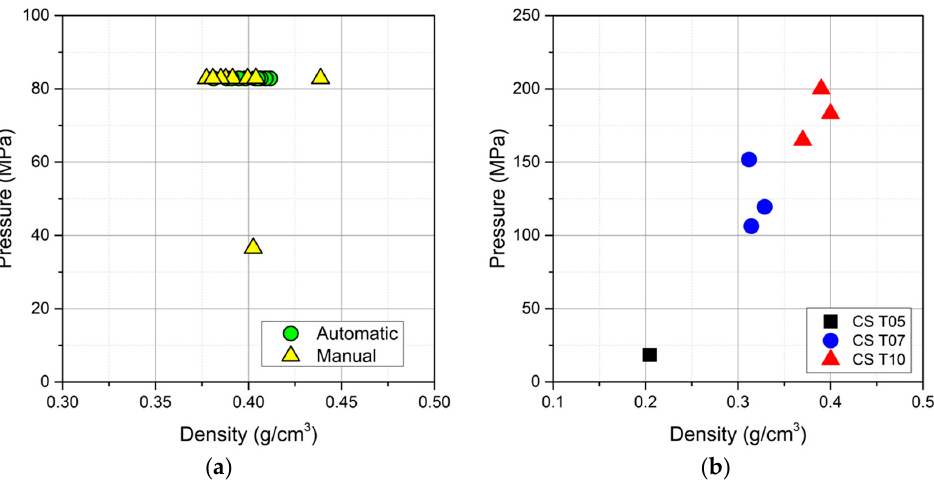
Figure 7. ( a ) proof test results at isostatic compressive pressure (83 MPa) for alumina CS T10 ceramic spheres (* sphere imploded); ( b ) a failure pressure test for the alumina ceramic spheres with various wall thicknesses (CS T10, CS T07 and CS T05).